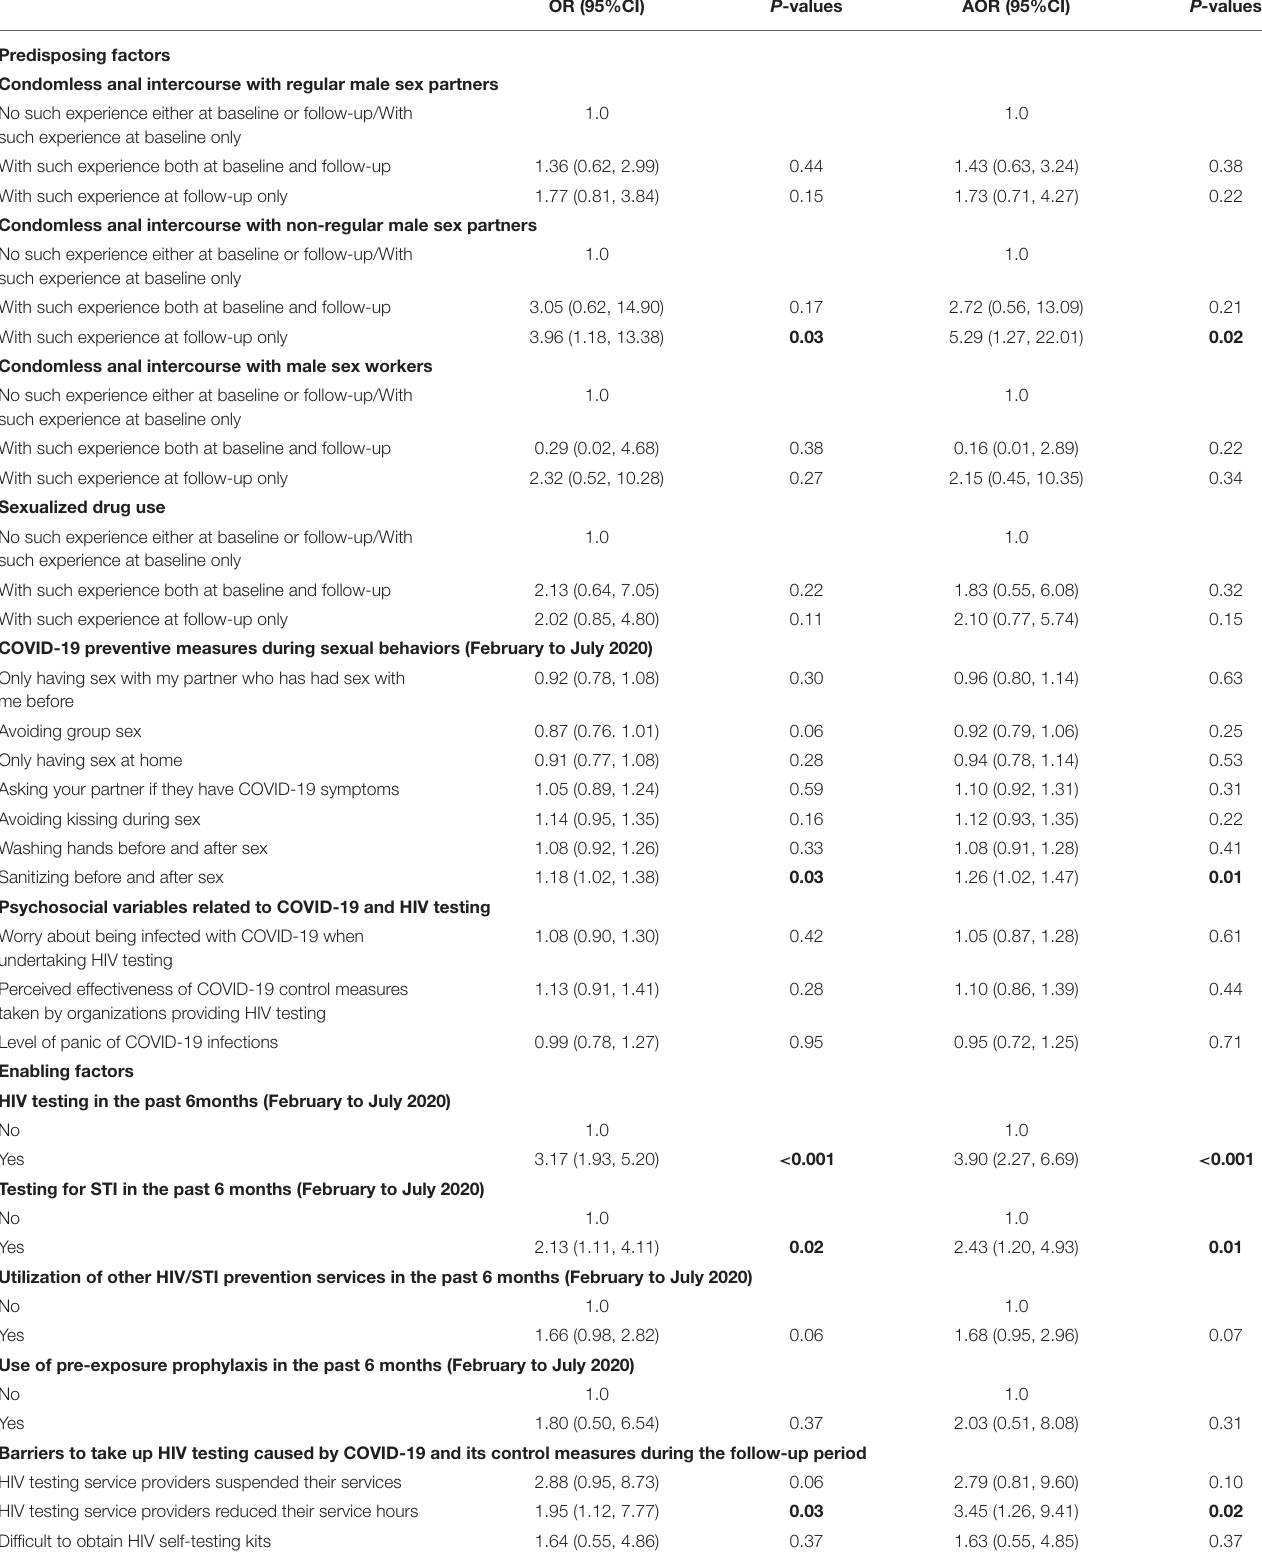
TABLE 5 | Factors associated with uptake of any type of HIV testing during the follow-up period (among participants who completed both surveys, n = 297). OR (95%CI) P -values AOR (95%CI) P-